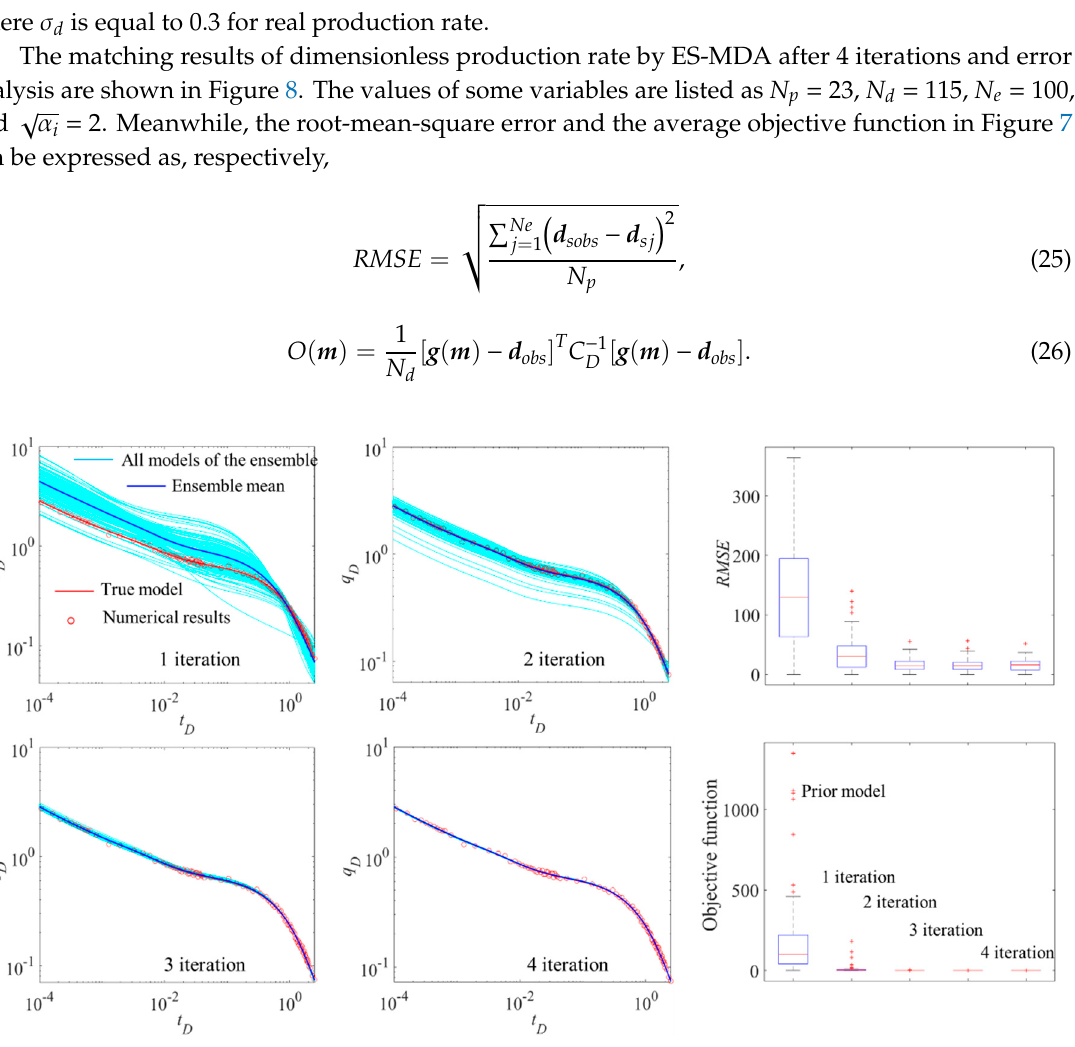
Figure 8. The matching results of dimensionless production rate by ensemble smoother with multiple data assimilation (ES-MDA) after 4 iterations and error analysis.